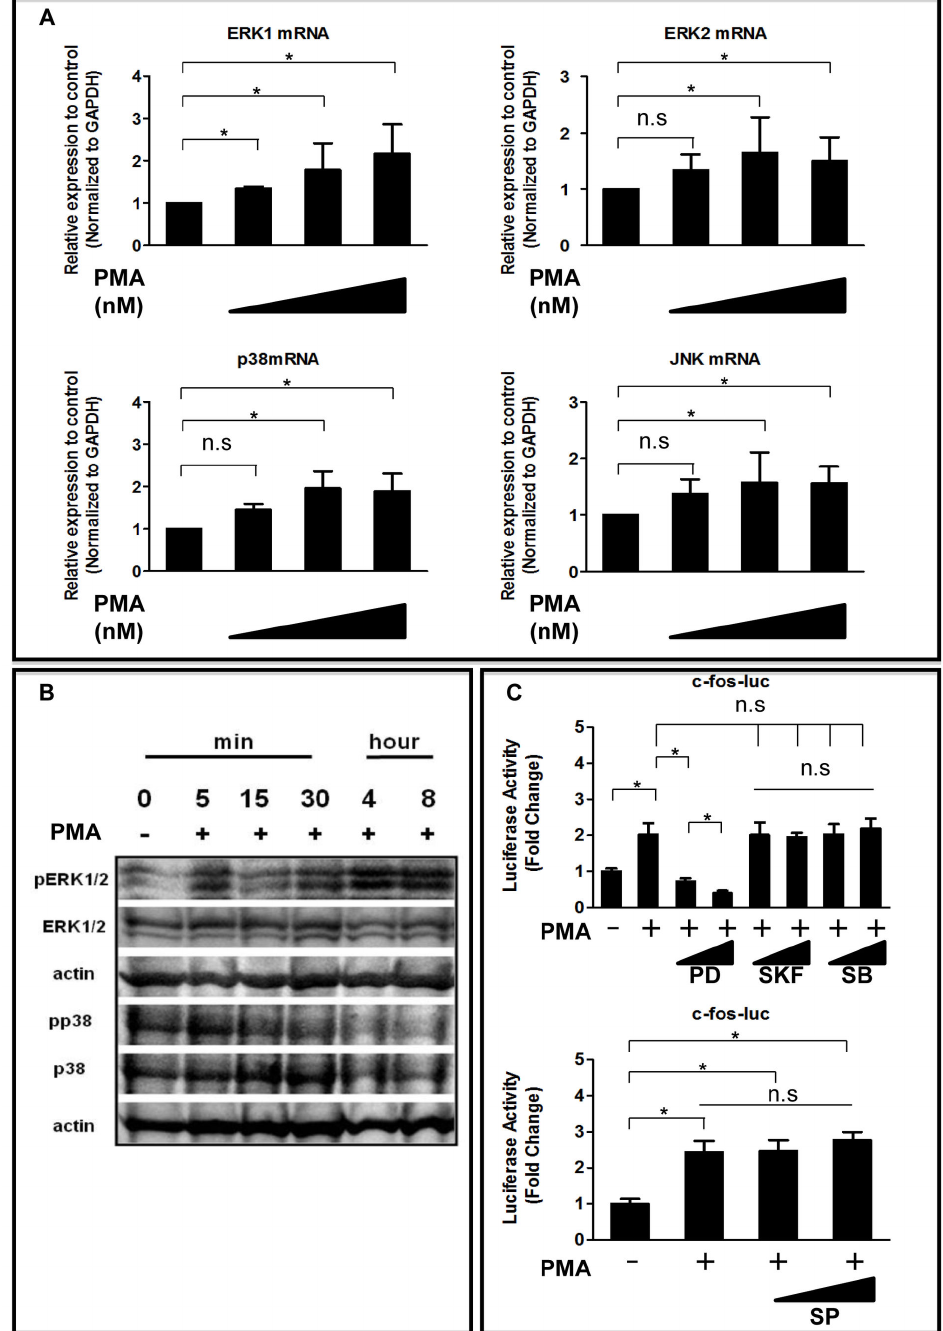
Figure 4. Effect of PMA on MAPK regulation of c-fos expression in NP cells. ( A ) ERK1 , ERK2 , p38 , and JNK mRNA expression after exposure of NP cells to PMA (0-200 nM) for 24 h assessed by real-time RT-PCR. ( B ) Western blot analysis of ERK and p38 activation following treatment of NP cells with PMA. After 1-day of serum deprivation, NP cells were treated with vehicle (control) or 200 nM PMA. The same blots were stripped and reprobed with antibodies for total and phosphorylated proteins of ERK or p38. β-actin was detected as a loading control. ( C ) NP cells were transfected with the c-fos reporter plasmid. The transfected cells were then treated with PMA with or without the MAPK inhibitors PD98059 (PD, 30 or 50 μM), SKF86002 (SKF, 5 or 20 μM), SB202190 (SB, 1 or 10 μM), or SP600125 (SP, 1 or 10 μM) for 24 h. * P < 0.05 indicates significant differences between groups; n.s. = not significant. doi: 10.1371/journal.pone.0073210.g004 PLOS ONE |